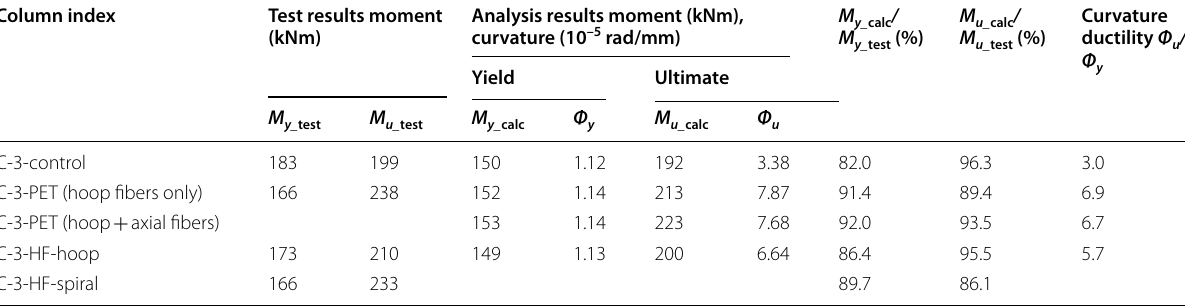
Table 5 Results of moment – curvature analyses versus test results: TG‑3